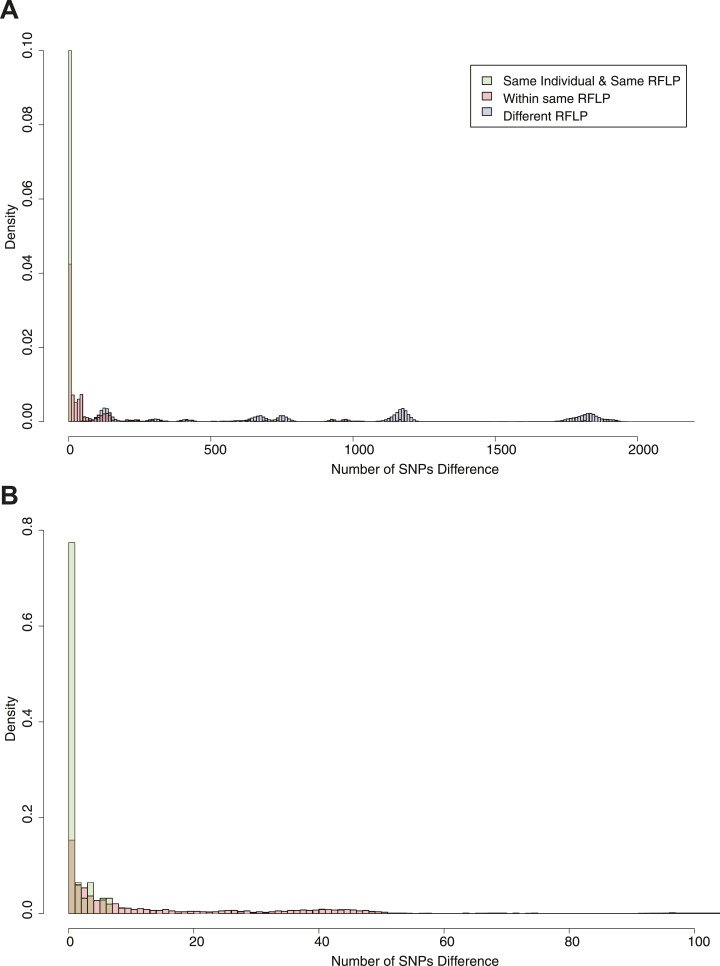
Pairwise SNP distances between all pairs of samples with known
RFLP.The y axis shows the relative frequency within each subgroup: same RFLP
pattern (red), different RFLP patterns (blue); same individual, same RFLP
(green). (A) shows the full data set, and (B)
is part of the same figure drawn at a larger scale (each bar corresponds
to 1 SNP) to show the smaller distances more clearly.